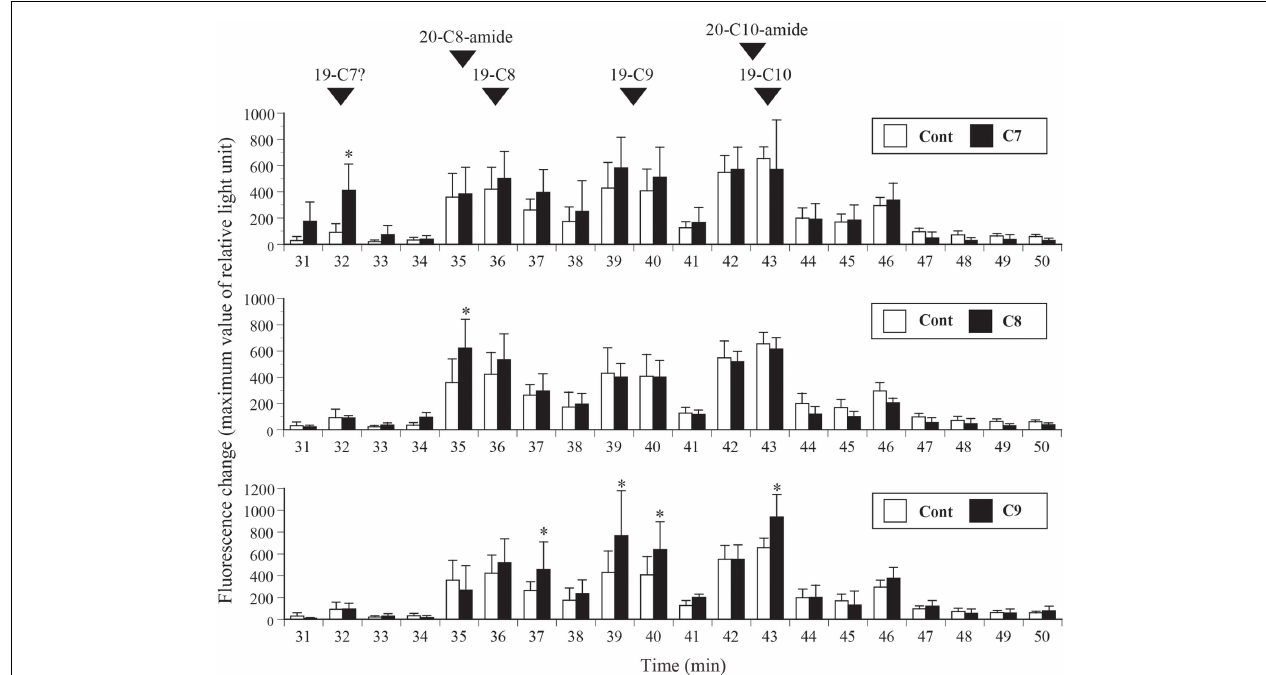
protected least significant difference test. Differences were considered significant at P < 0.05.The elution times of isolated native barfin flounder ghrelin, C8-ghrelin with 19 amino acids (aas) (19-C8), C9-ghrelin with 19 aas (19-C9), C10-ghrelin with 19 aas (19-C10), C8-ghrelin with 20 aas and C-terminal amidation (20-C8-amide), and C10-ghrelin with 20 aas and C-terminal amidation (20-C10-amide) are indicated by arrowheads.The expected elution time of C7-ghrelin with 19 aas (19-C7) is also indicated; the time is based on the results for 19-C8, 19-C9, and